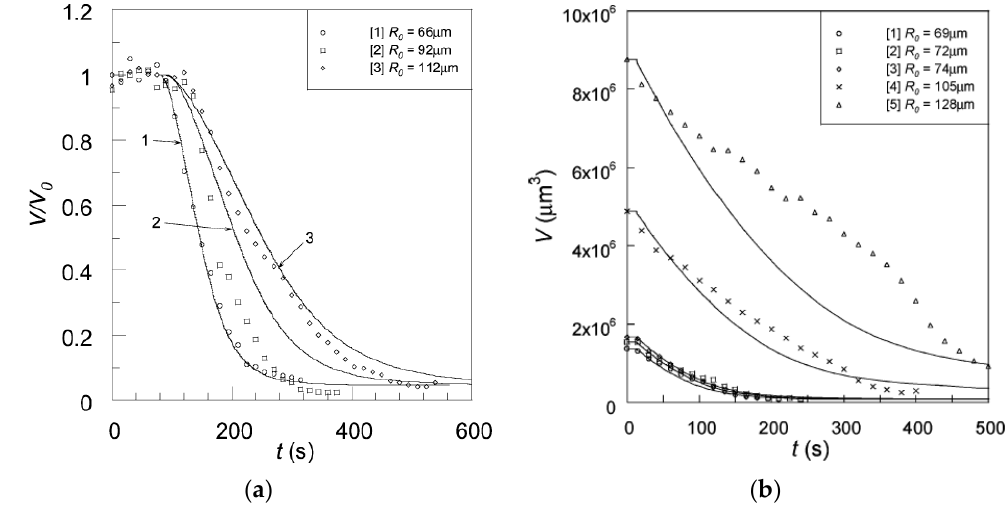
Figure 23. ( a ) Deswelling kinetics for PA-microgels gels of different size in 0.56 mM C 12 TABr, 10 mM NaBr. Relative volume as a function of time for seven different sized gels, with corresponding theoretical lines, is shown. ( b ) Same type of data for PA-microgels in 0.20 mM C 16 TABr, 10 mM NaBr. Figures taken from ref. [65,76]. Figure ( a ) Reprinted with permission. Copyright 2005 American Chemical Society. Figure ( b ) Reprinted with permission. Copyright 2007 American Chemical Society.